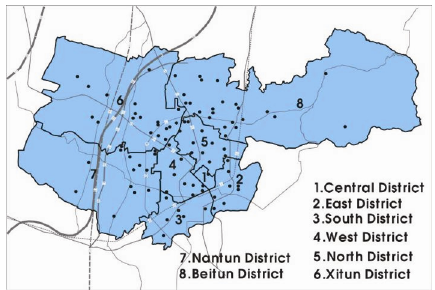
Fig. 6(b). The distribution of schools in the downtown of Taichung City